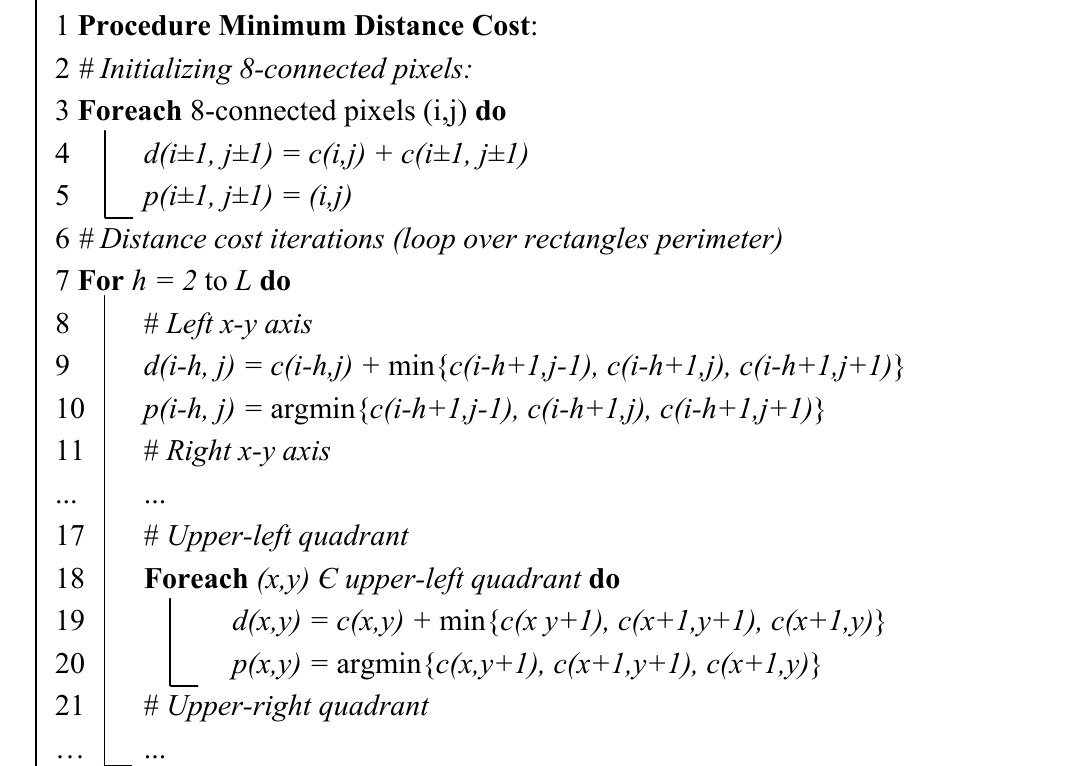
Algorithm 1. Pseudo code of the distance cost